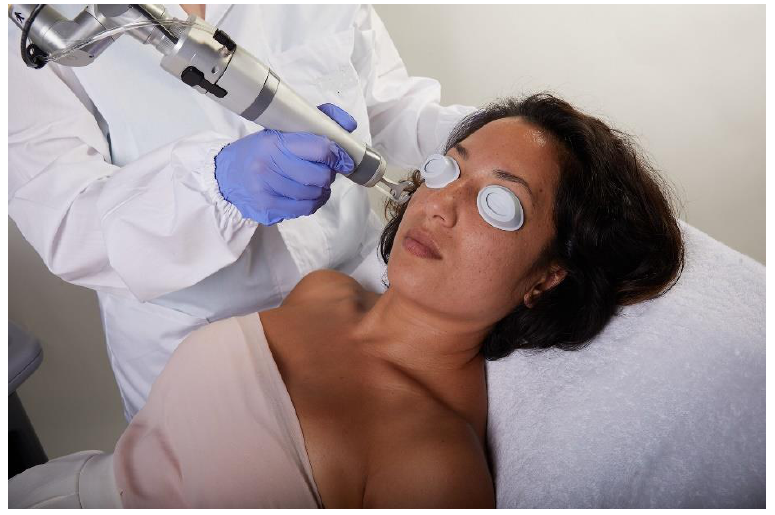
Figure 1. Figure of the Q-Switched system.